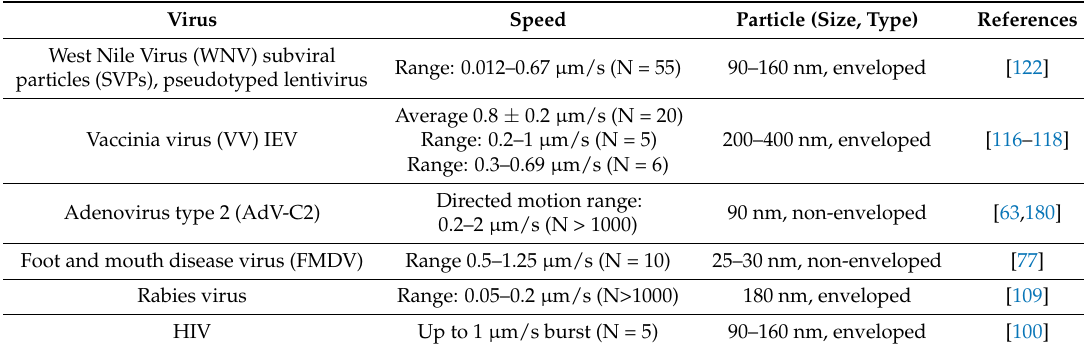
Table 4. Virion speeds on